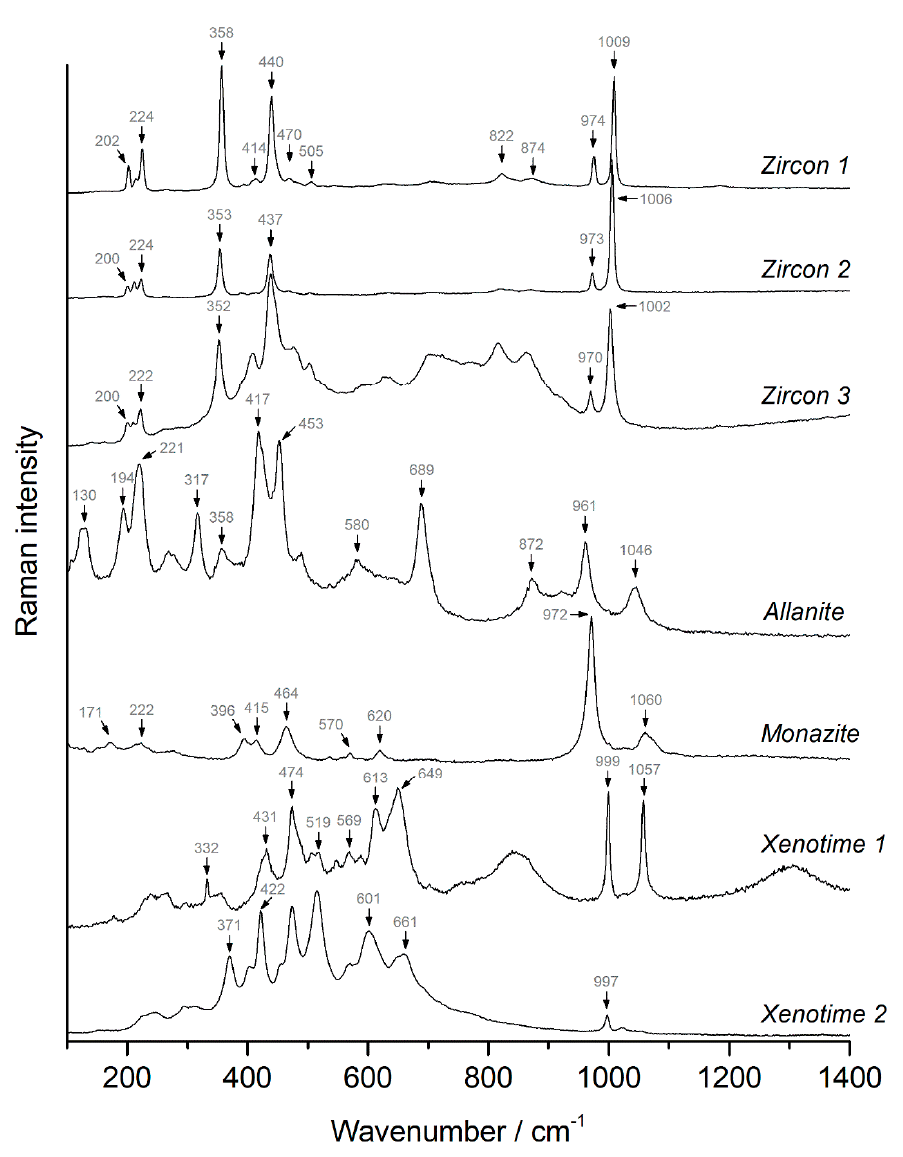
Figure 3. The Raman spectra of selected REE minerals: zircon, allanite, monazite and xenotime.